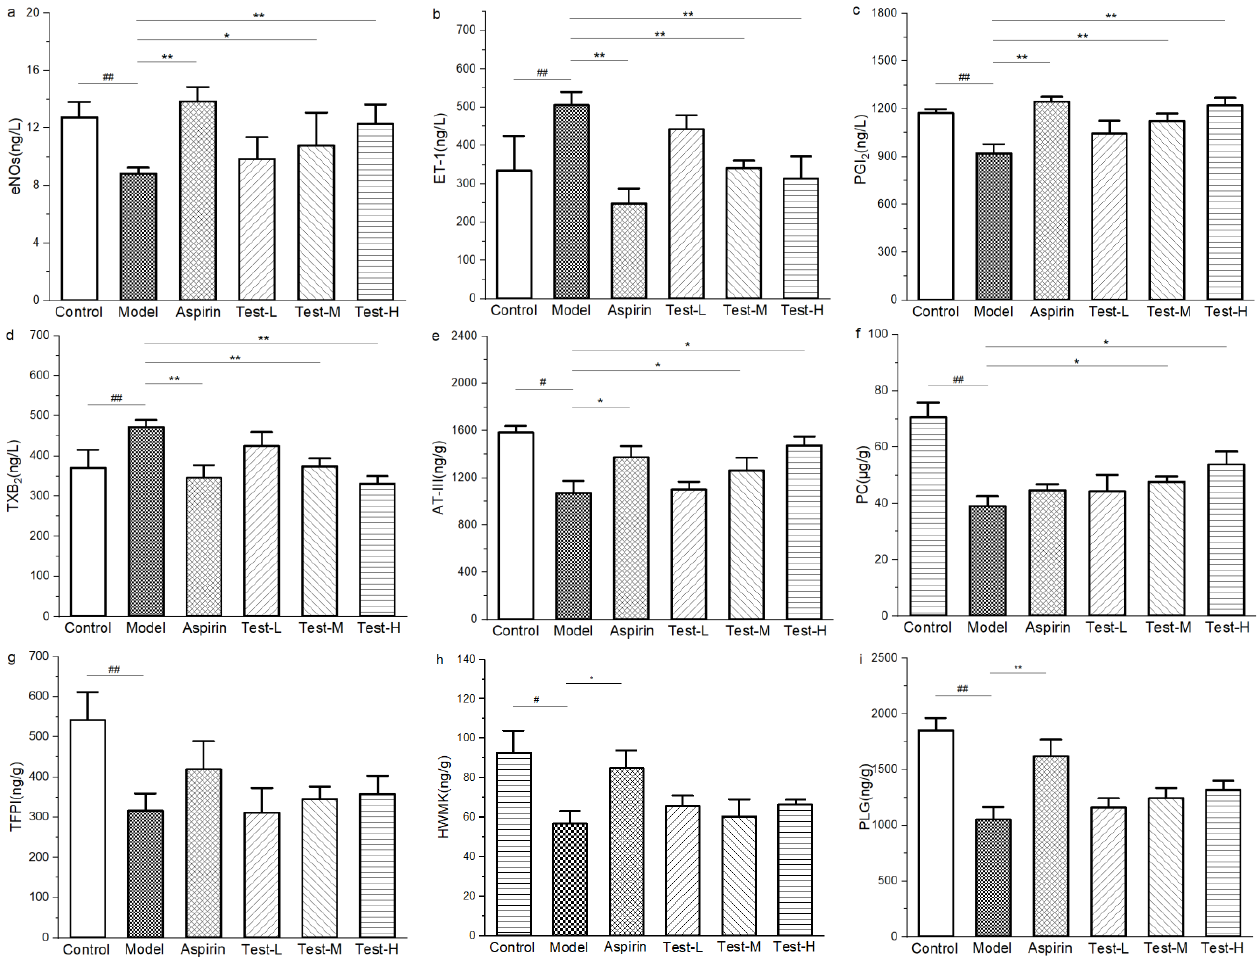
Figure 8. Effects of AAP-b2 on nitric oxide synthases (eNOs) ( a ), endothelin-1 (ET-1) ( b ),